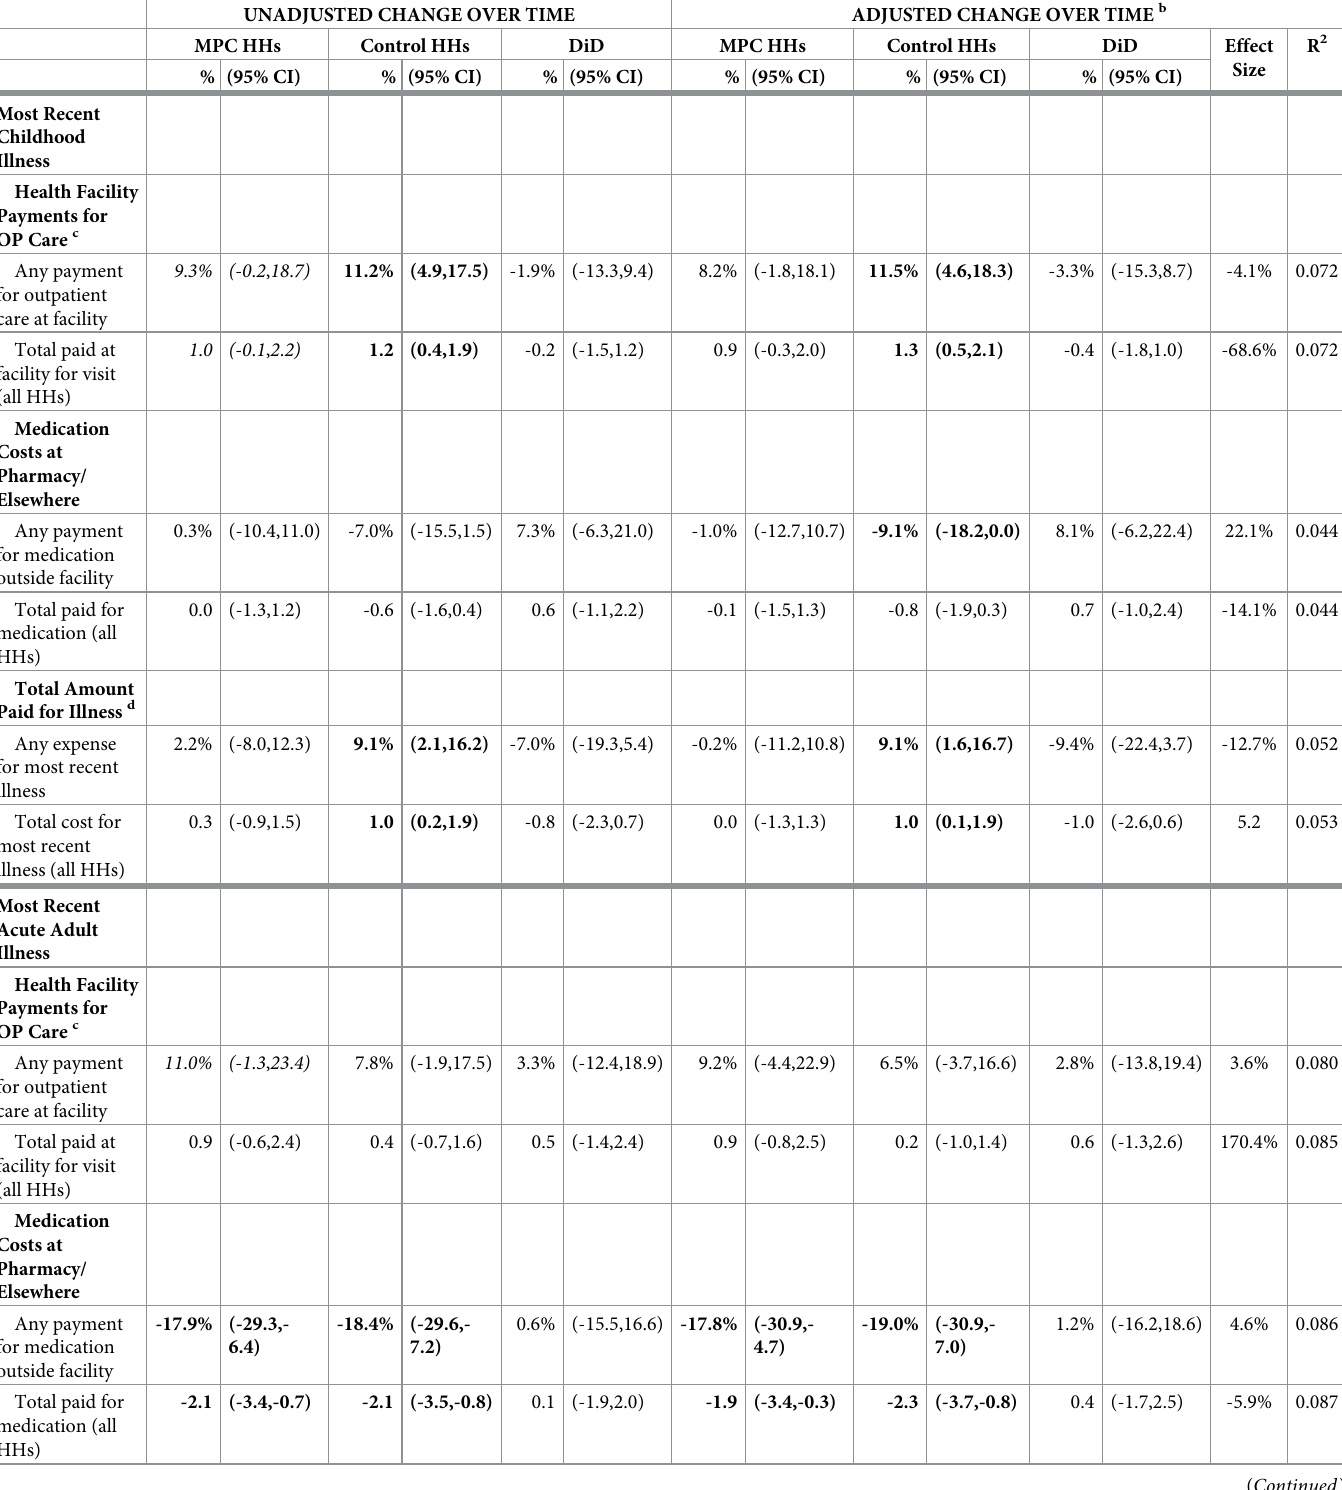
Table 5. Change in log health expenditures for most recent care and in the preceding month a . UNADJUSTED CHANGE OVER